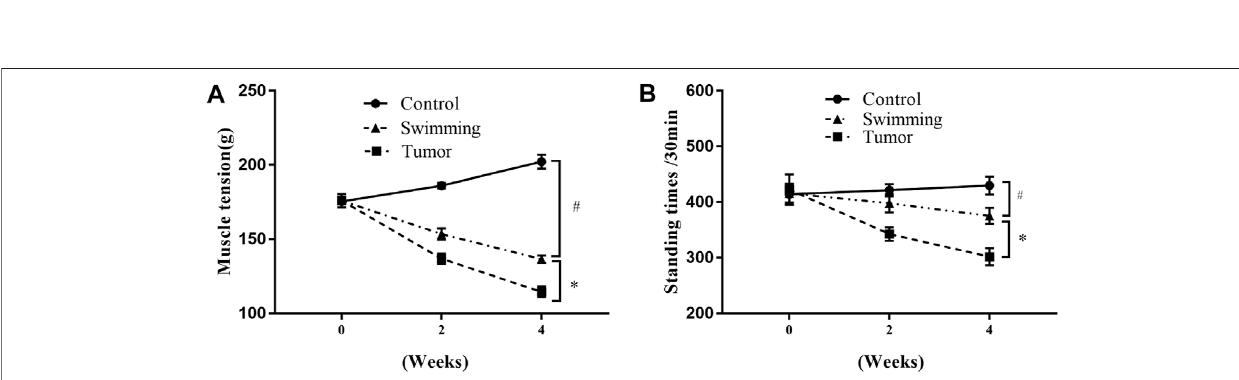
FIGURE 1 | Effects of swimming on tumor volume and tumor weight of CT-26 bearing mice. (A) Tumor volume was monitored during the exercise period for 28 days. (B) Tumor weight was determined by electronic scale at the end of the experiment. Data are present as mean ± SD. * p < 0.05, vs Tumor.